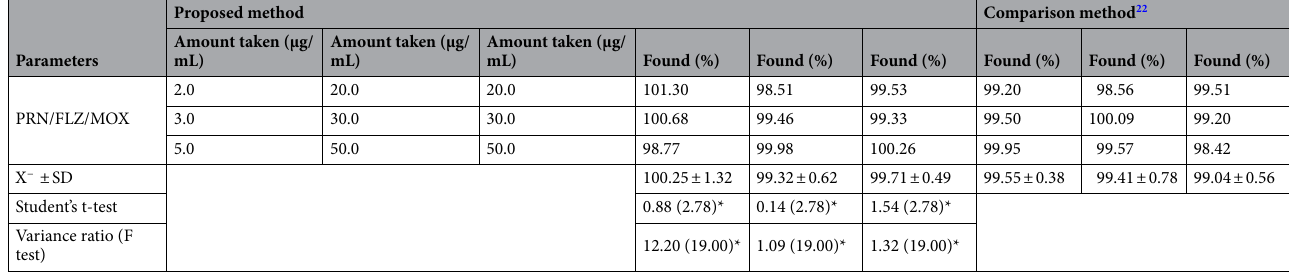
Table 4. Assay results for the determination of the studied drugs in laboratory-prepared gel. *Values between parentheses are the tabulated t and F values 31 .